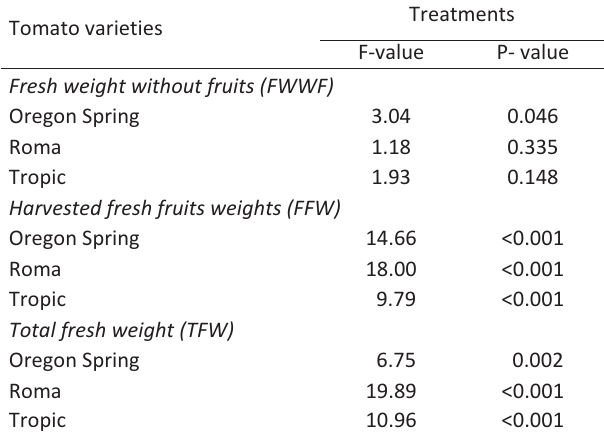
Table 2 ­ ANOVA (F­value and P­value) comparing the impact of the treatments on the harvested fresh fruits and aerial biomass measurements that developed on three varie­ ties of tomato (OregonSpring, Roma and